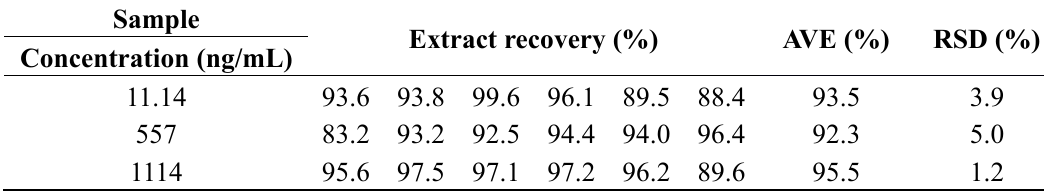
Table 7. Extraction recovery of TA-III from spiked rat plasma (n = 6).